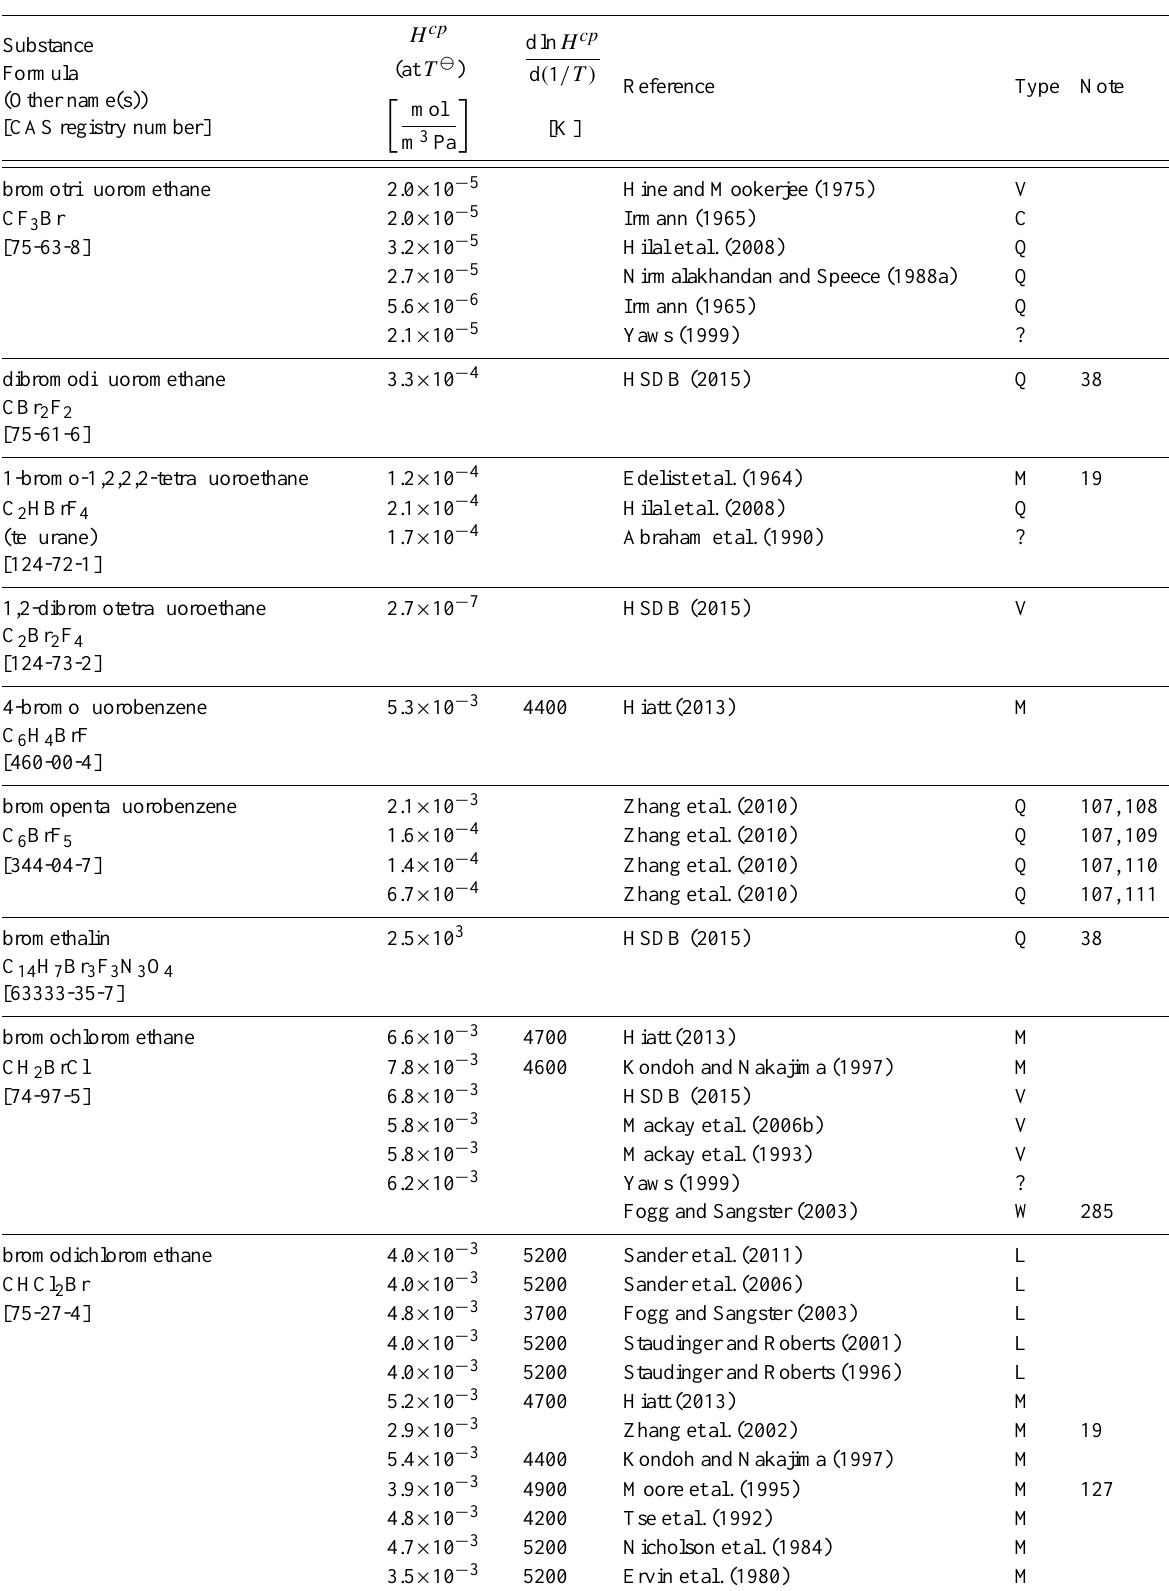
Table 6: Henry’s law constants for water as solvent